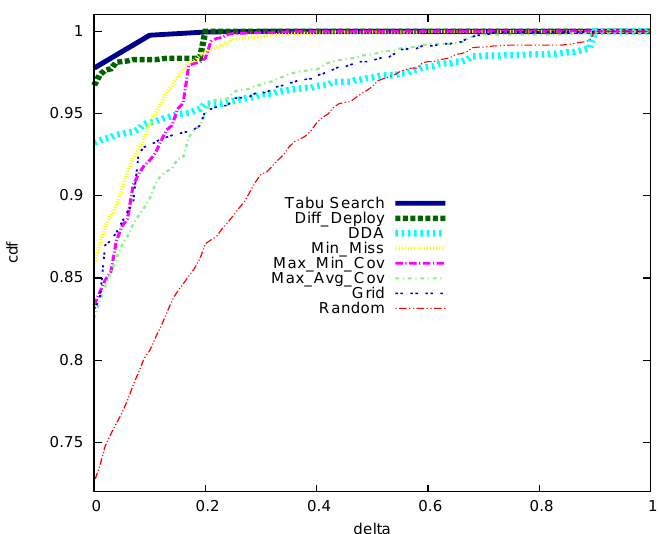
Figure 4. cdf between desired and obtained detection